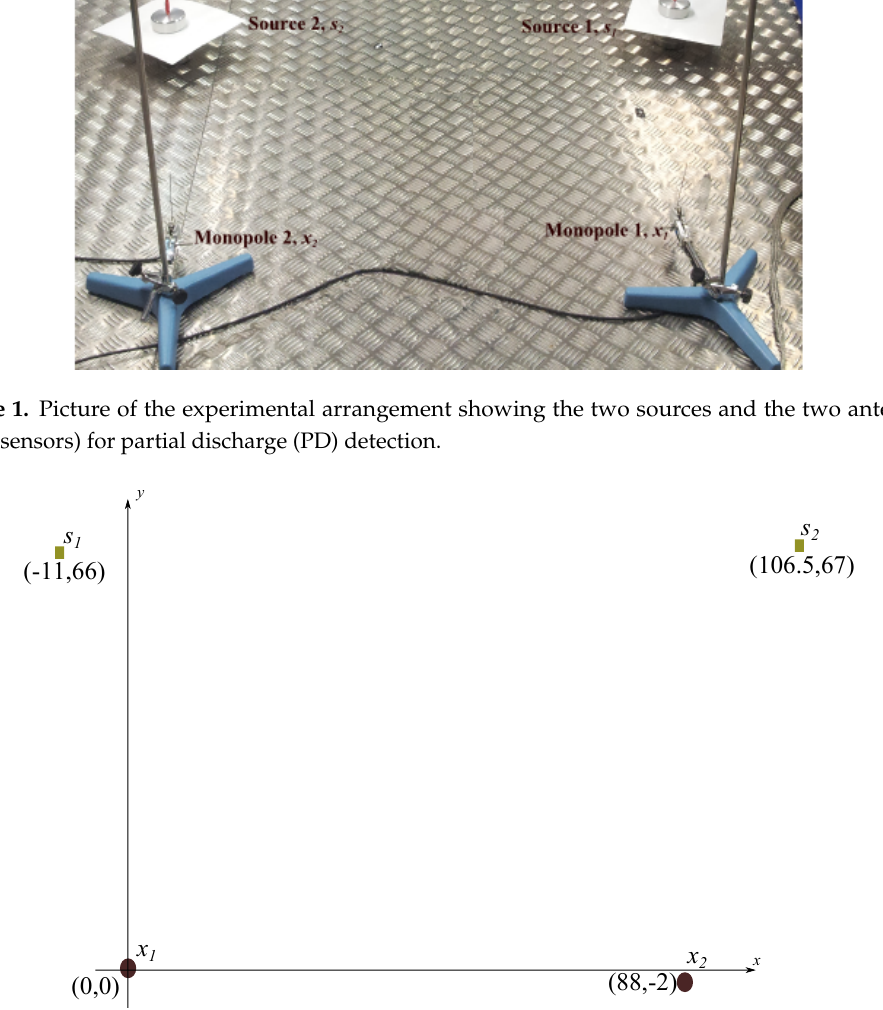
Figure 2. Positions of sources and sensors. Cartesian coordinates are in